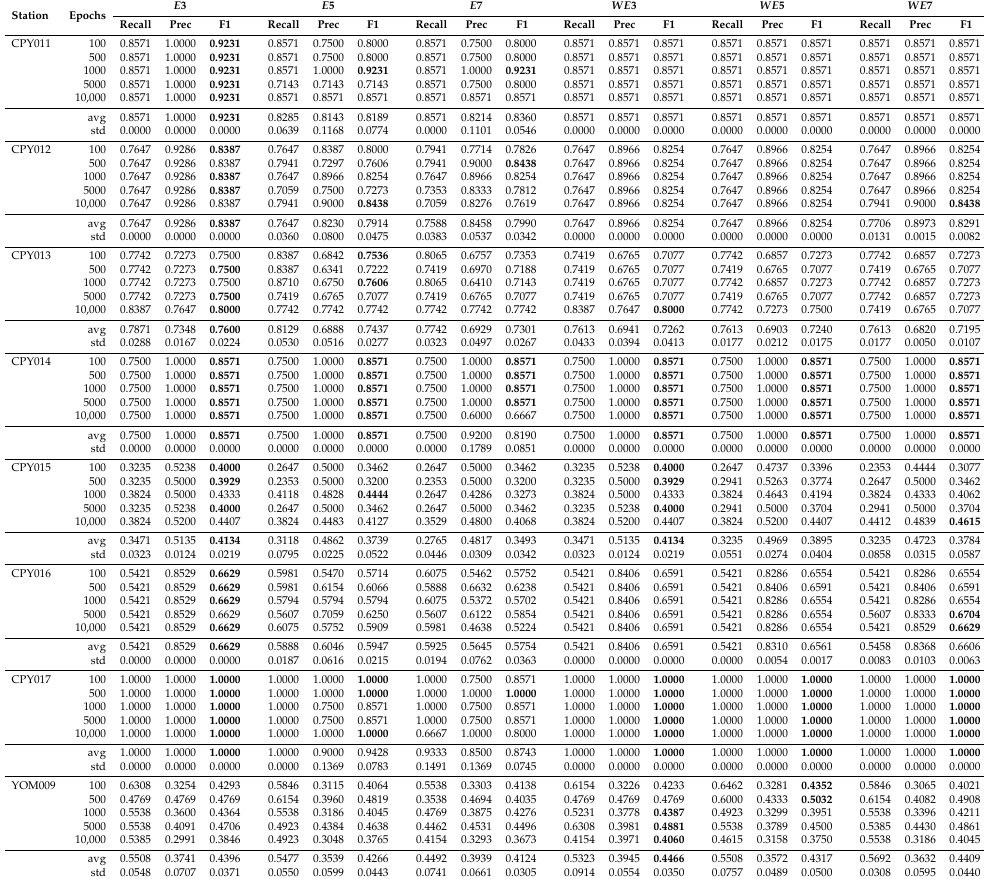
Table 12. The performance of the ensemble models built by combining DRL and candidate models (the best F1-score of each row is shown in bold).